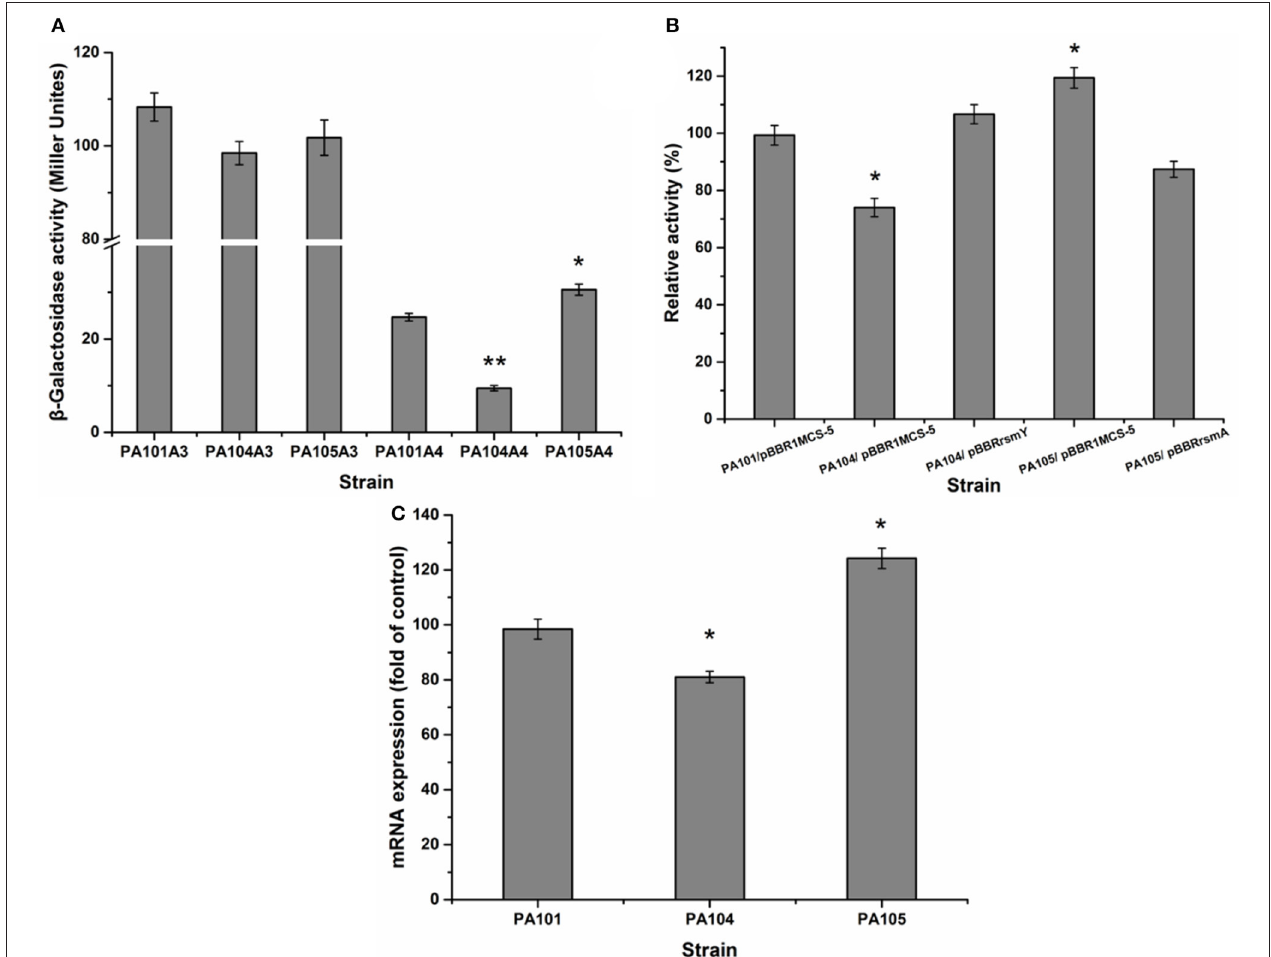
FIGURE 4 | Effect of rsmY and rsmA mutants on lipA expression. (A) Effect of rsmY and rsmA mutants on expression of chromosome-located translationally fused lipA-lacZ (bar 1, control strain PA101A3; bar 2, rsmY-mutant strain PA104A3; bar 3, rsmA-mutant strain PA105A3) and chromosome-located transcriptionally fused lipA’-‘lacZ (bar 4, control strain PA101A4; bar 5, rsmY-mutant strain PA104A4; bar 6, rsmA-mutant strain PA105A4). After inoculating β -galactosidase into M9 medium (50ml), the activity of strains was determined in stationary phase. (B) Relative lipase activity in PA101/pBBR1MCS-5, PA104/pBBR1MCS-5, PA104/pBBRrsmY, PA105/pBBR1MCS-5, and PA105/pBBRrsmA. (C) Expression of lipA in wild-type strain PA101 (lane 1), PA104 (lane 2) and PA105 (lane 3) by qRT-PCR. Experiments were in triplicate. * P < 0.05, ** P < 0.01 compared with control strain.